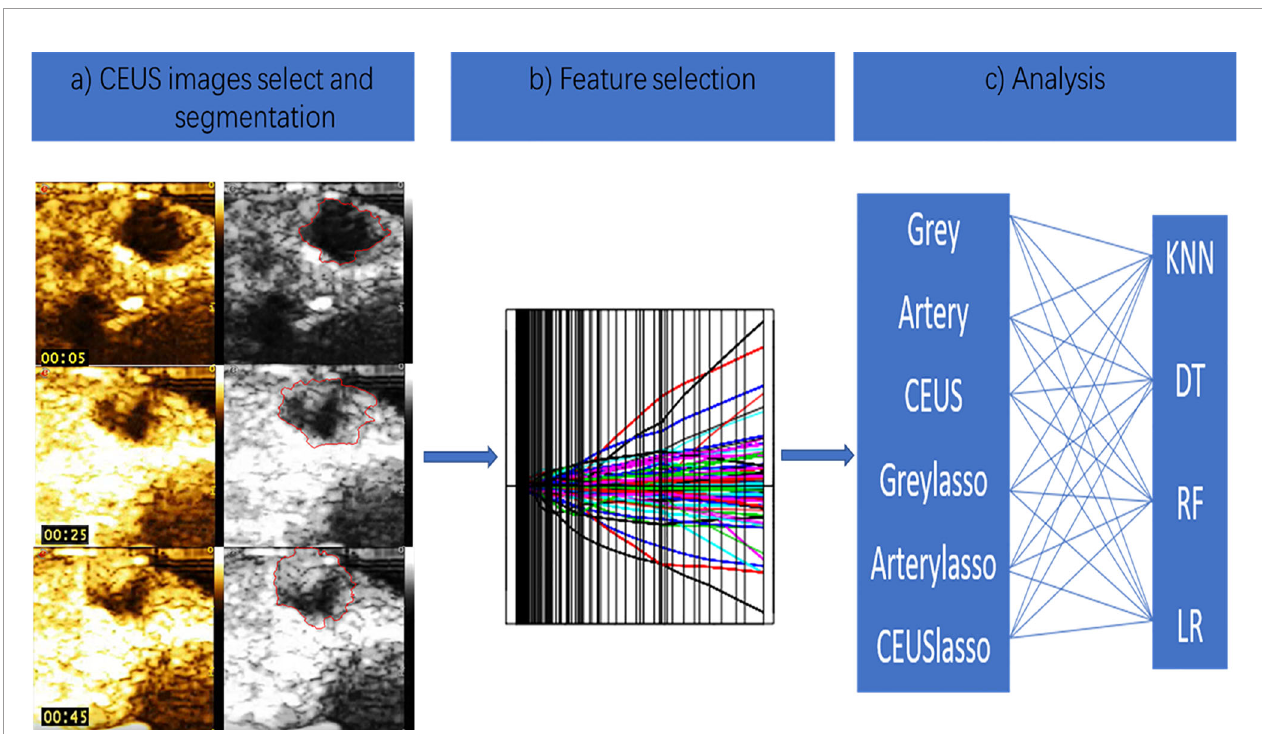
FIGURE 2 | The CEUS-based radiomics analysis schematic. (A) The CEUS images of mouse was extracted at 5,25 and 45 seconds. (B) Lasso regression was used as feature selection method. (C) Four supervised machine learning algorithms were